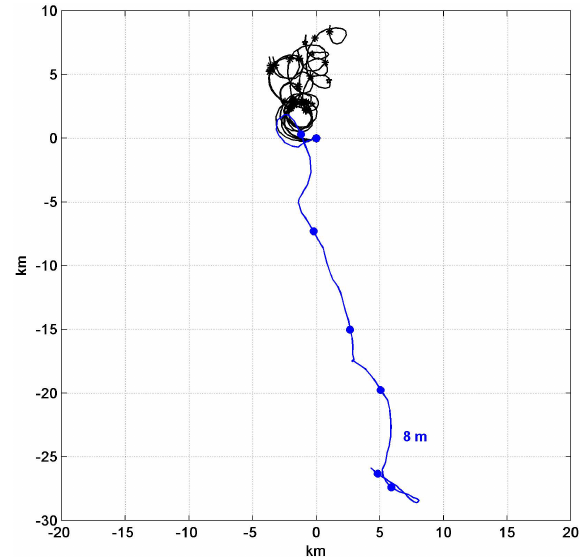
Fig. 9. Progressive Vector of hourly mean data of currents from 23rd to 25th of February 2004. Markers indicate 12h